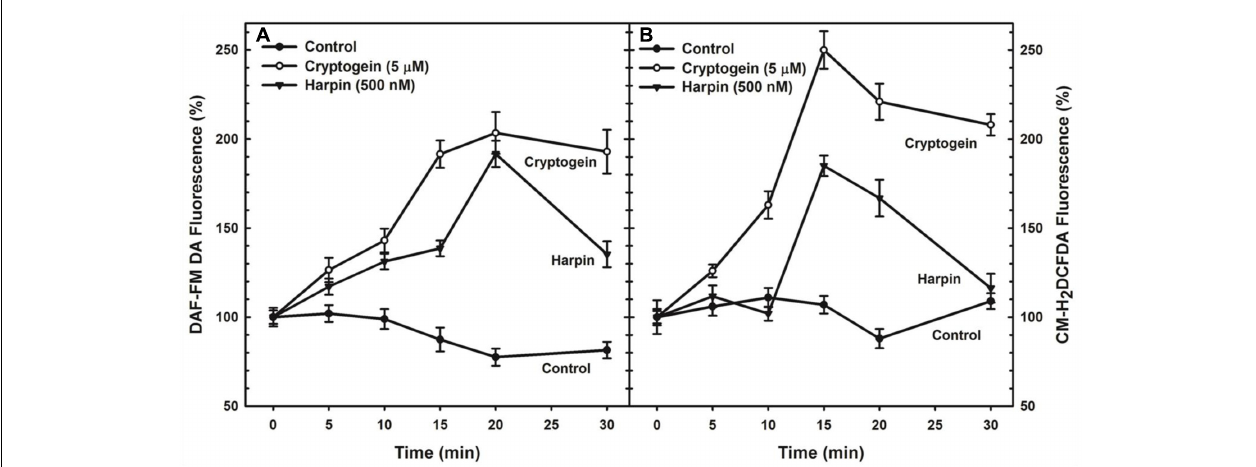
FIGURE 3 | Kinetic studies of NO (A) or ROS (B) production in guard cells in response to cryptogein and harpin. The levels of NO or ROS raised from 0 to 30 min in the guard cells in response to two microbial elicitors compared with that of untreated guard cells. The fluorescence which is emitted by fluorescent probes, DAF-FM DA or CM-H 2 DCFDA in response to cryptogein and harpin was quantified for every 5 min and plotted in the graph. The data plotted in the graph are the averages of three different experiments on three different days. Further details are in section “Materials and Methods.”